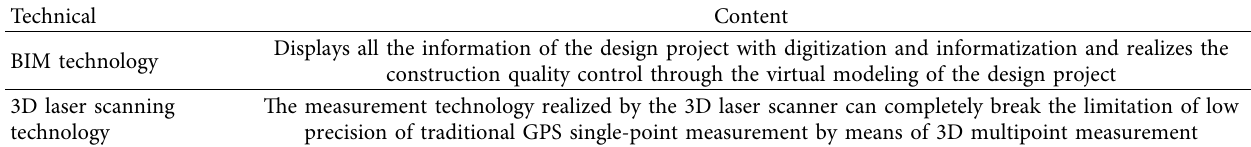
Table 1: Introduction of methods and techniques.